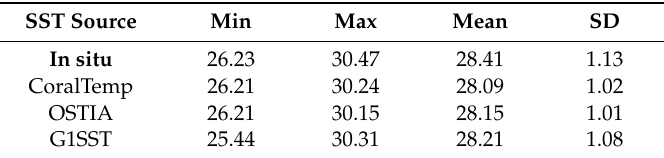
Table 3. Summary of the sea surface temperature (SST) data ( ◦ C) for Cayo Enrique and Cayo Mario